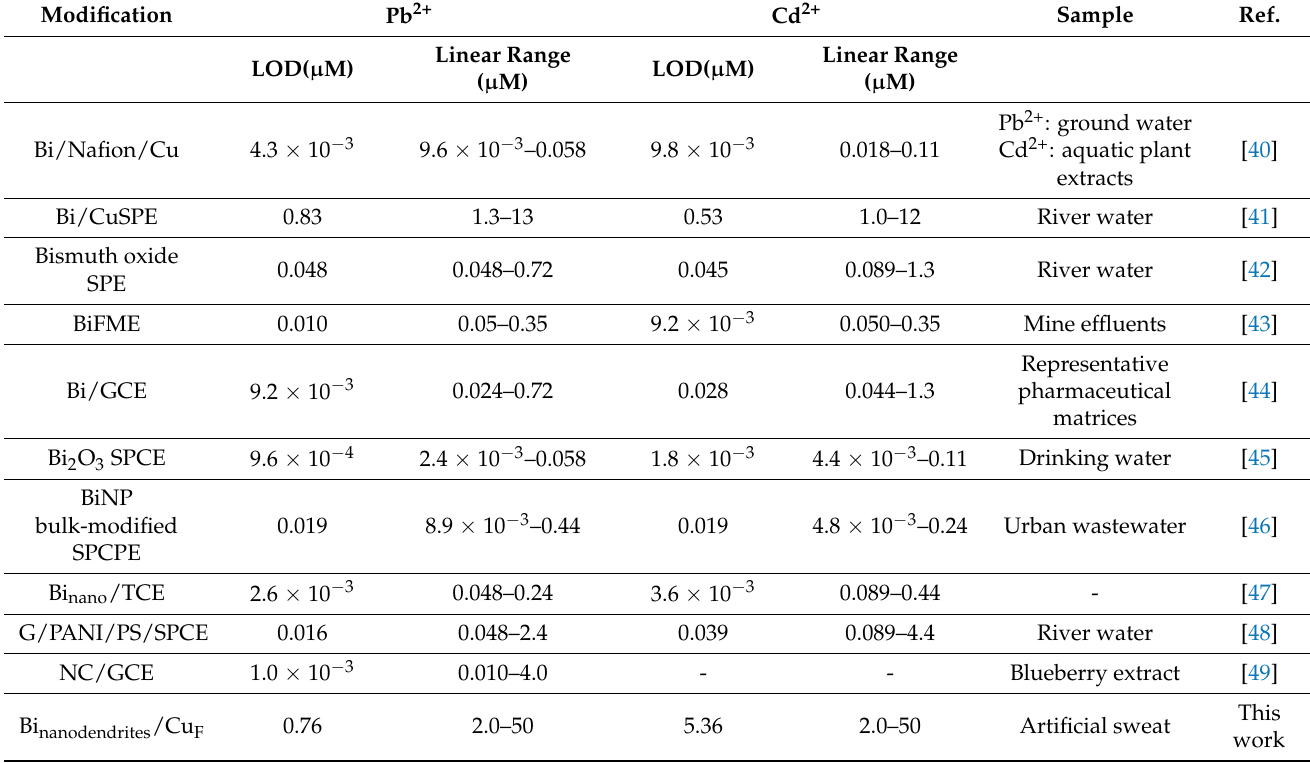
Table 1. Figures of merit for Pb 2+ and Cd 2+ ions detection using devices functionalized with bismuth. Due to the limited studies on sensors modified with bismuth micro- nano-structures for determi- nation of Pb 2+ and Cd 2+ ions on relevant biological fluids, figures of merit are also included for environmental